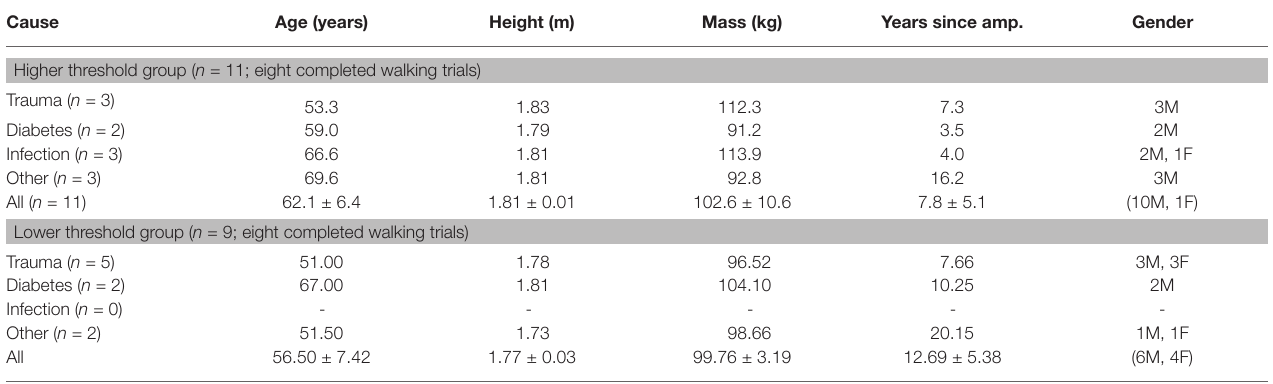
TABLE 1 | Participant